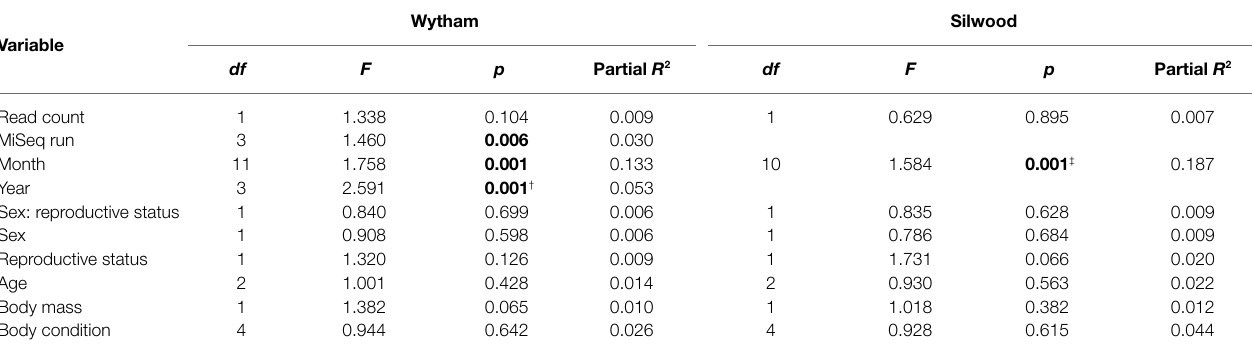
TABLE 1 | Predictors of microbiota composition in two populations of wild mice.